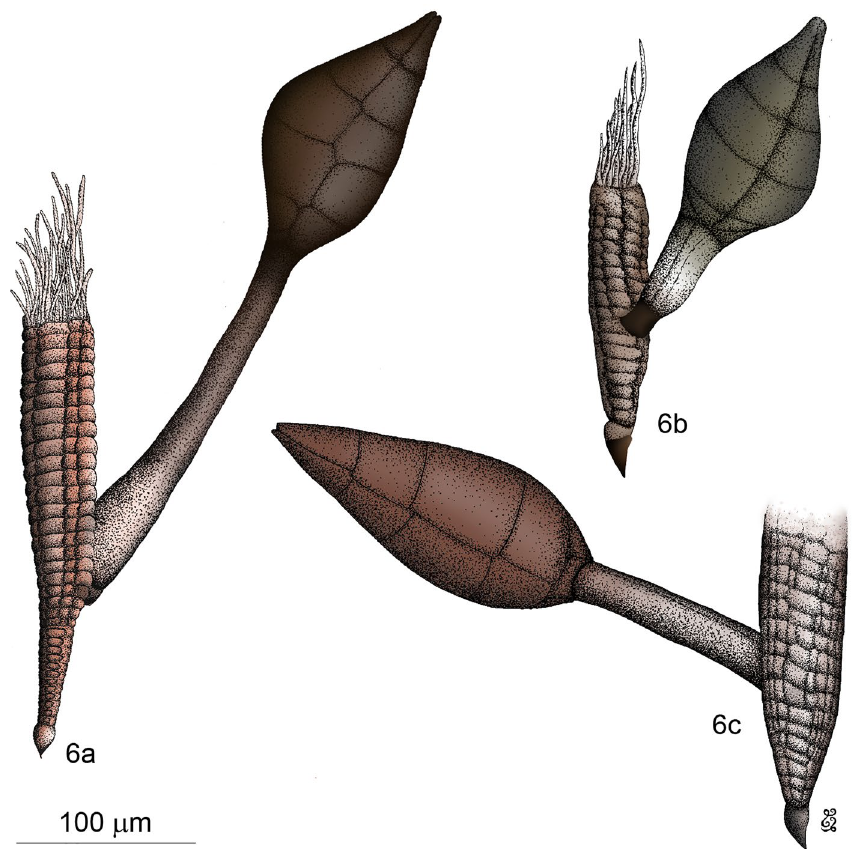
Figure 6. Genus Columnomyces . ( a ) C. peckii sp. nov., mature thallus. ( b ) C. hispaniolensis sp. nov., mature thallus. ( c ) † C. electri sp. nov., mature thallus, artist’s interpretation. Scale bar: 5a = 100 μm: b–5c = 50 μm. Drawings by Jingyu Liu.